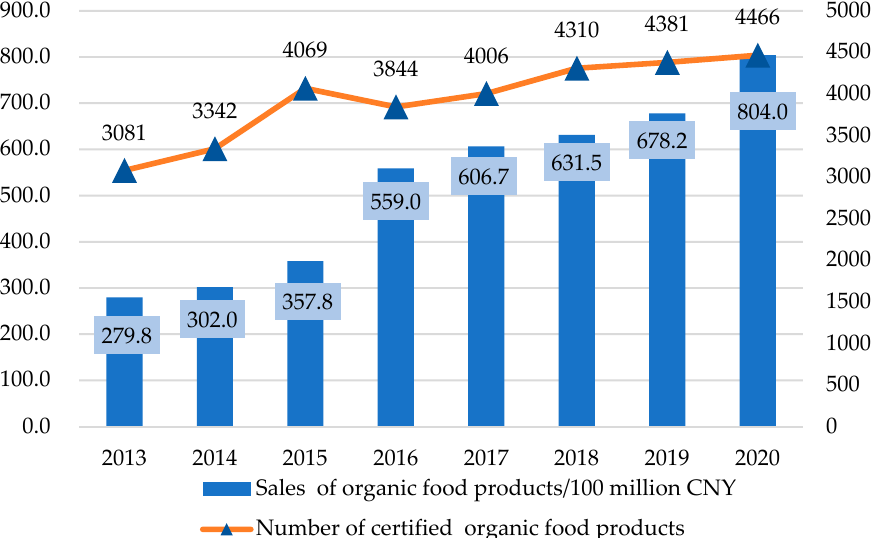
Figure 1. Trends of Chinese Organic Food Products. (Source: Green Food Development Center China and Prospective Industry Research Institute.)